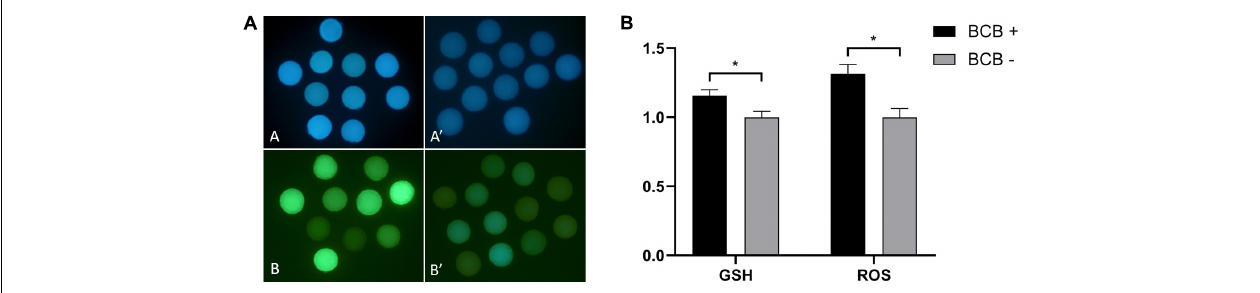
FIGURE 2 | Epifluorescence photomicrographic images of in vitro mature porcine oocytes. (A) Glutathione (GSH; A,A (cid:48) ) and reactive oxygen species (ROS; B,B (cid:48) ) in oocytes in the brilliant cresyl blue-stained (BCB +) ( A,B ) and non-stained (BCB − ) ( A (cid:48) ,B (cid:48) ) oocyte groups. (B) Intracellular levels of GSH and ROS in in vitro mature porcine oocytes in the BCB + and BCB − oocyte groups. Values are means ± SEM ( n = 8 replicates). Asterisks indicate P ≤ 0.05 when compared with each other. TABLE 2 | In vitro development of porcine parthenogenetic embryos derived from brilliant cresyl blue-stained (BCB + ) and non-stained (BCB − ) oocytes. Group No. of COCs No. (%) of M-II oocytes No. (%) of embryos Total cell number in blastocysts Cleaved Developed to BL Control 160 BCB + BCB − Values in the same column with different superscript letters are significantly different (p < 0.05). Percentages are shown as means ± SEM (n = 4 replicates). BL, blastocyst; COC, cumulus–oocyte complex.